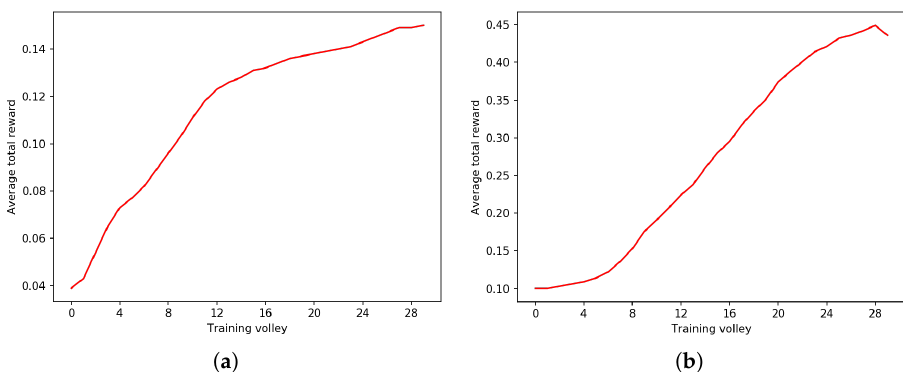
Figure 4. Experiment on BF with B = 400. The difference in the achieved average total reward per episode between ˆ π BF and π BF is similar to the case with B = 200, while the learning curve is different. Volleys are composed of 1000 episodes each, and the fixed length of each trajectory is T = 200 steps.